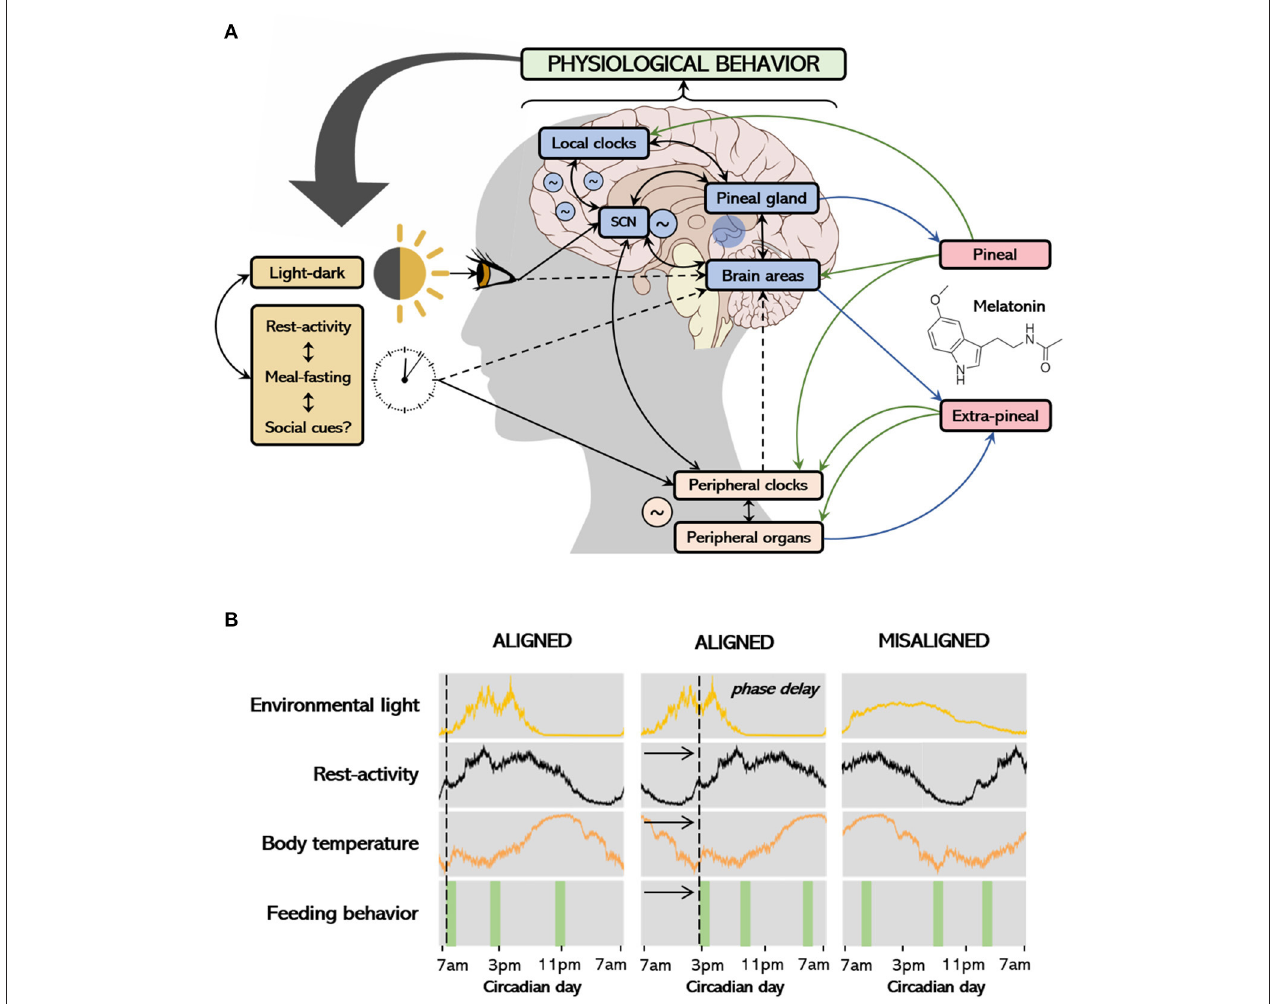
FIGURE 1 | Environmental and internal regulation of biological rhythms, melatonin production and associations with behavior (A) ; the process of entrainment and alignment (B) . The main environmental cue that synchronizes the circadian system is the light-dark cycle. The suprachiasmatic nucleus (SCN) receives photic information and projects to several structures in the body, coordinating peripheral tissues by modulating other oscillators according to light-dark transitions. Other stimuli of importance include feeding schedules, rest-activity rhythm and social cues. Peripheral tissues respond to timing neural and endocrine signals modulated by the SCN, including the release of melatonin to the bloodstream, as well as from feeding. On the other hand, endogenous circadian rhythms also influence daily patterns in behavior/exposure to environmental factors and might also influence melatonin production (see details in text). In (A) , black arrows connect the environmental stimuli to the central and peripheral clocks and tissues and show the interconnection among systems. Continuous arrows represent higher levels of evidence and dashed arrows represent lower levels of evidence. Melatonin is produced in the pineal gland, as a result of darkness or on-demand via other pathways (see details in text), acting locally or transducing the dark signal to peripheral tissues (green arrows). Extra-pineal sources of melatonin include the skin, guts, and lungs, which only act locally with no known chronobiotic effect. While the physiological actions of melatonin potentially impact behavior, individual behavior might also determine the timing of light exposure, rest-activity rhythms and feeding behavior, thus regulating melatonin secretion. The first column at (B) shows rhythms of activity, temperature, and feeding behavior aligned with the light signal; the second depicts rhythms which are phase delayed. The rhythms at the third column are no longer entrained to the light signal and are not synchronous within themselves, determining a